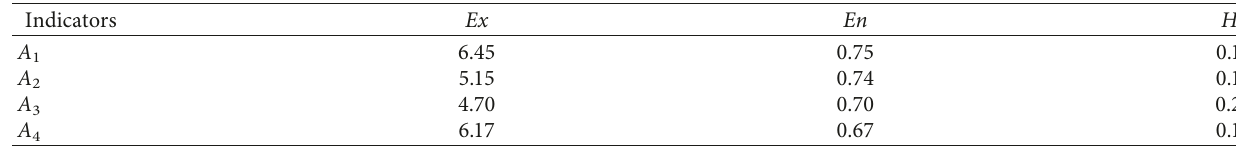
Table 5: First-level indicators of section ZK69+491 ∼ ZK70 +030.